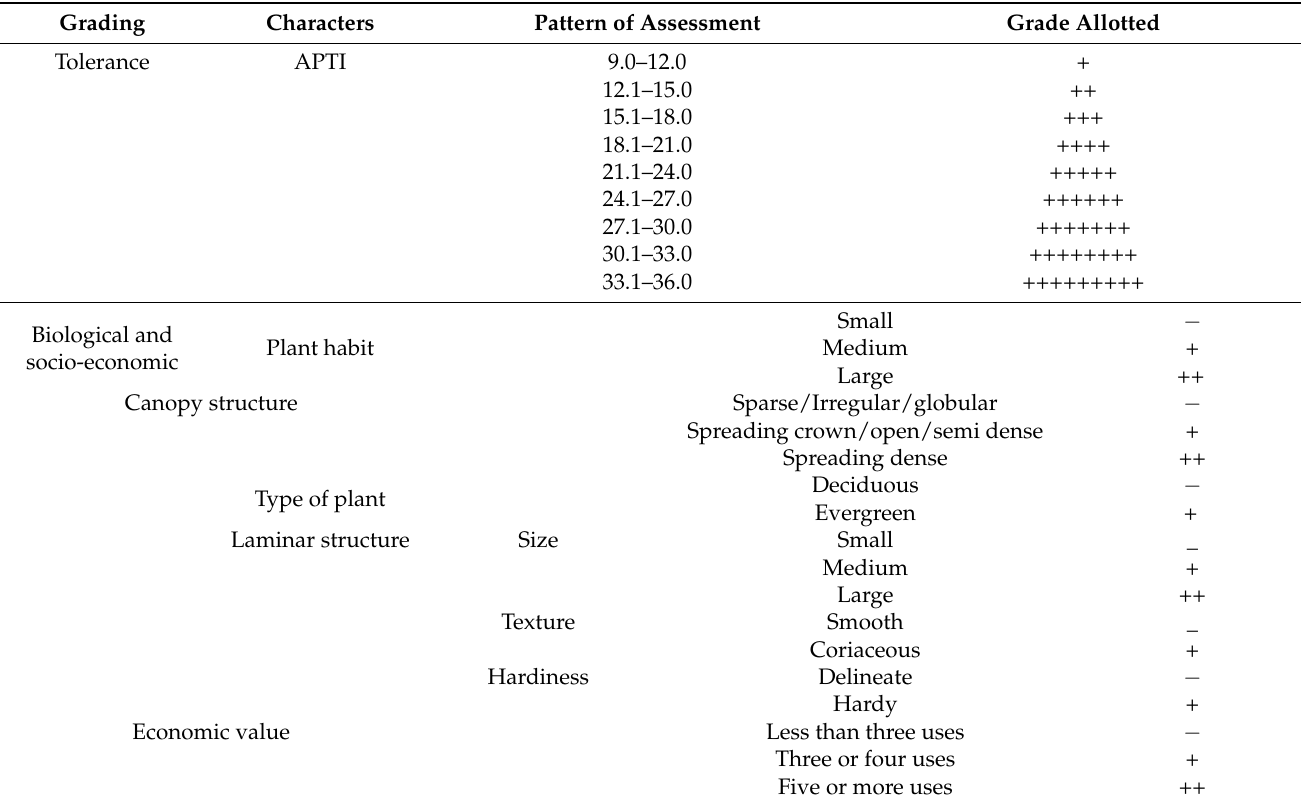
Table 2. Gradation of plant species based on APTI and other biological and socio-economic characters.